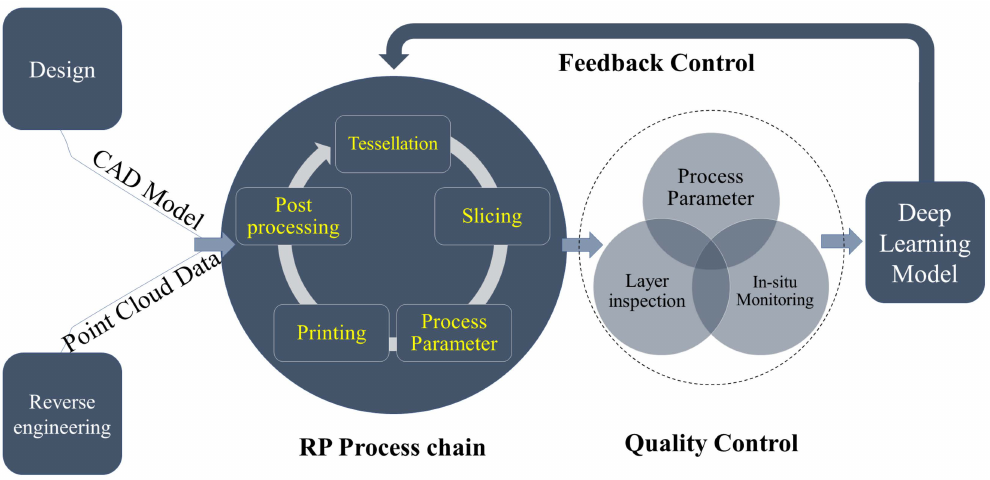
Figure 4. Incorporation of deep learning in AM